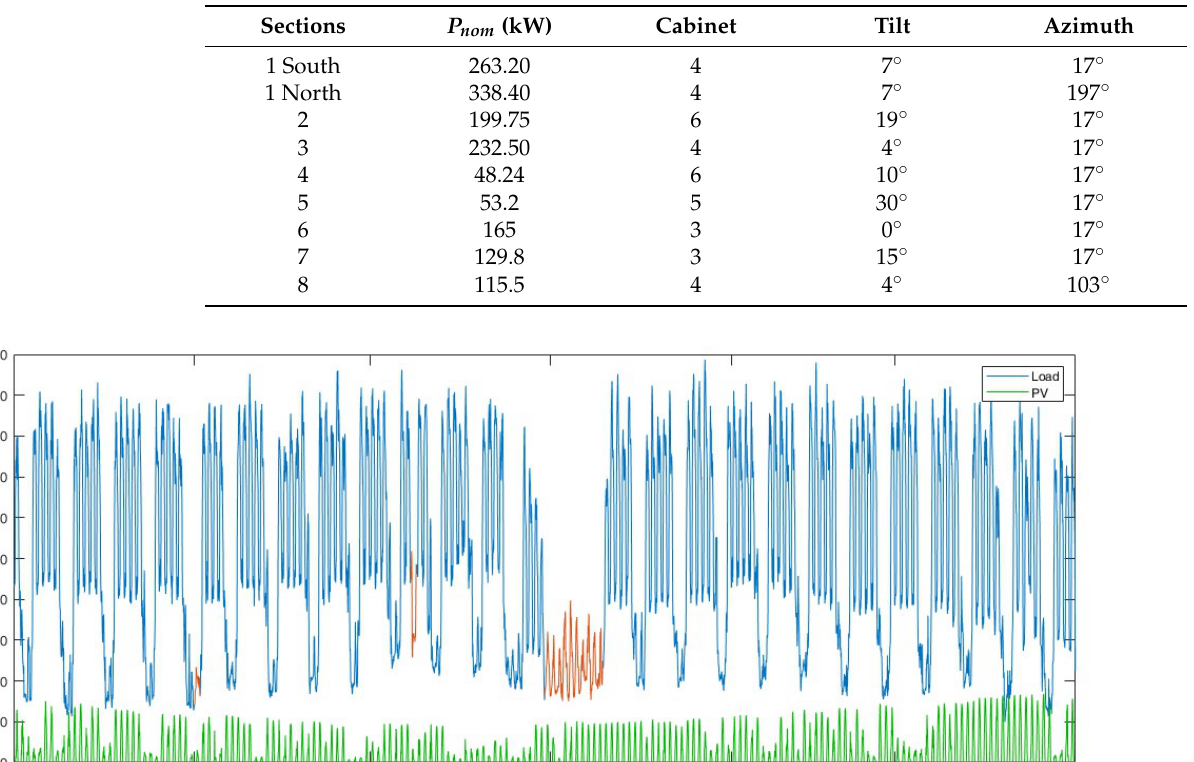
Table 1. PV plant characteristics.